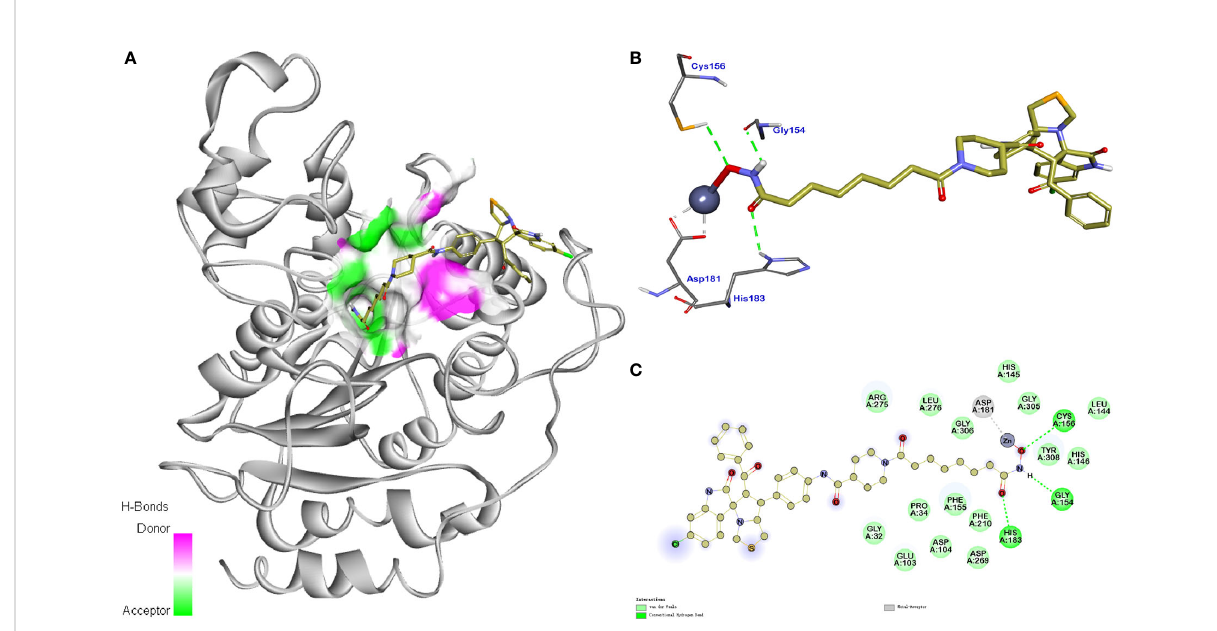
FIGURE 8 Synthesis of compounds 5a - 5v . Reagents and conditions: (A) 1 (1.0 equiv), 2 (1.0 equiv), 3 (1.0 equiv), MeOH, 65°C, 4 h; (B) Fe (10.0 equiv), NH